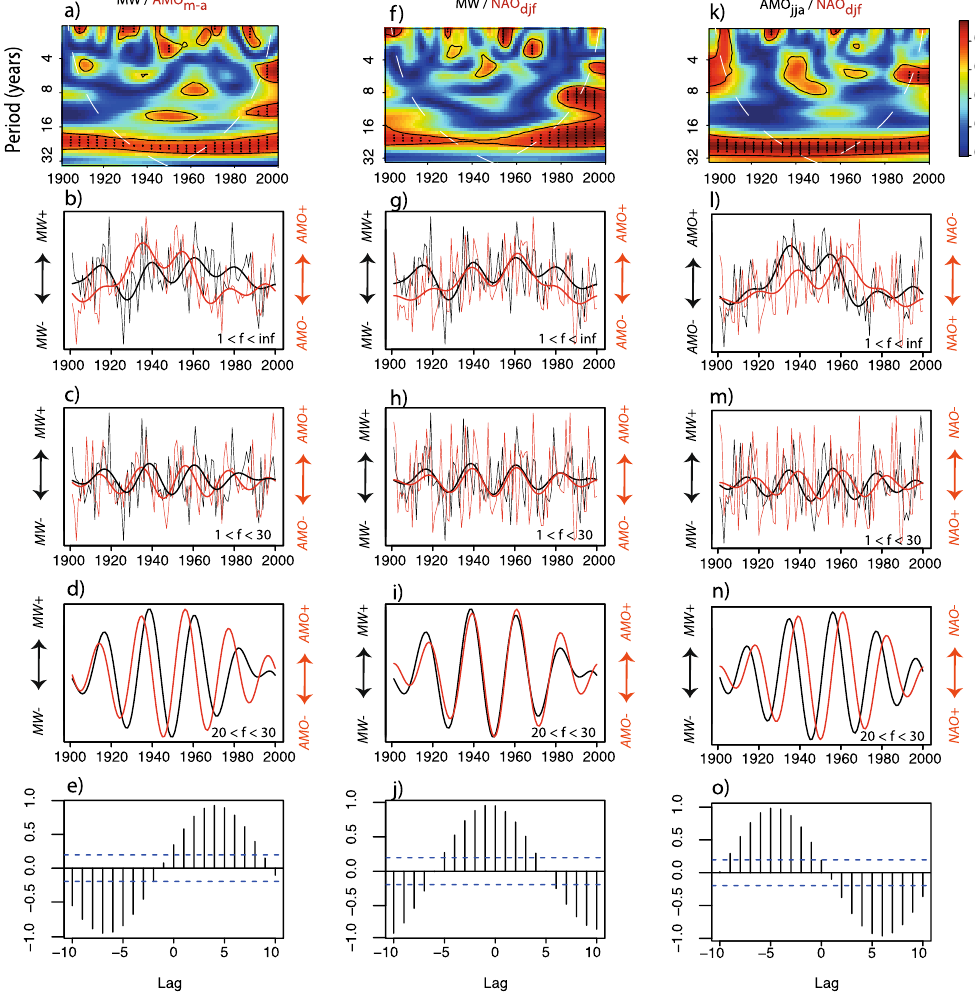
Figure 6. Relationships between MW and the summer AMO (first column), between MW and winter NAO index (second column). ( a ) Cross-spectral coherency analysis between MW and summer AMO, with significant coherencies appearing in bold. ( b ) Raw (full spectrum) MW and summer AMO time series. ( c ) Both time series with frequencies ( f ) > 30 years filtered out. ( d ) Both time series with frequencies < 20 years and > 30 years filtered out. ( e ) Lagged correlation analysis performed on 20 < f < 30 series ( d ), lagging AMO. The second and third columns are identical to the first one; however, the series compared are MW and winter NAO (second column, ( f – j ) and winter NAO and summer AMO (third column, ( k – o